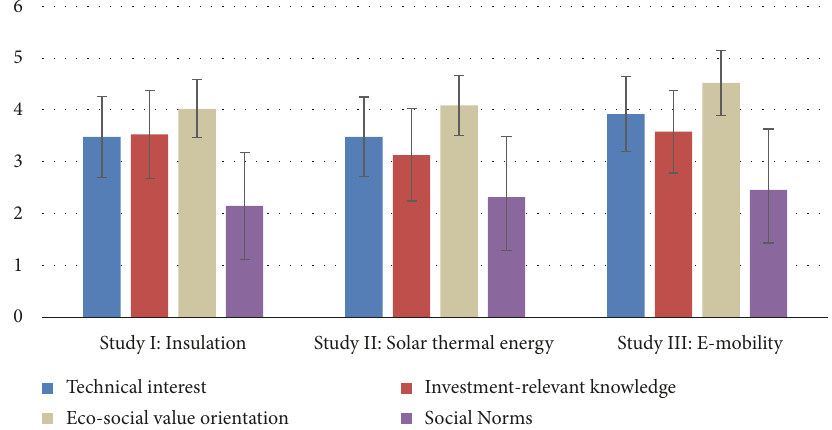
Figure 5: Descriptive data (means and standard deviations) of the independent variables and scales measured within the studies. Most items were measured on a 5-point Likert scale. In studies I and II, investment-relevantknowledge was measured on a 6-point Likert scale. The items were standardized for further